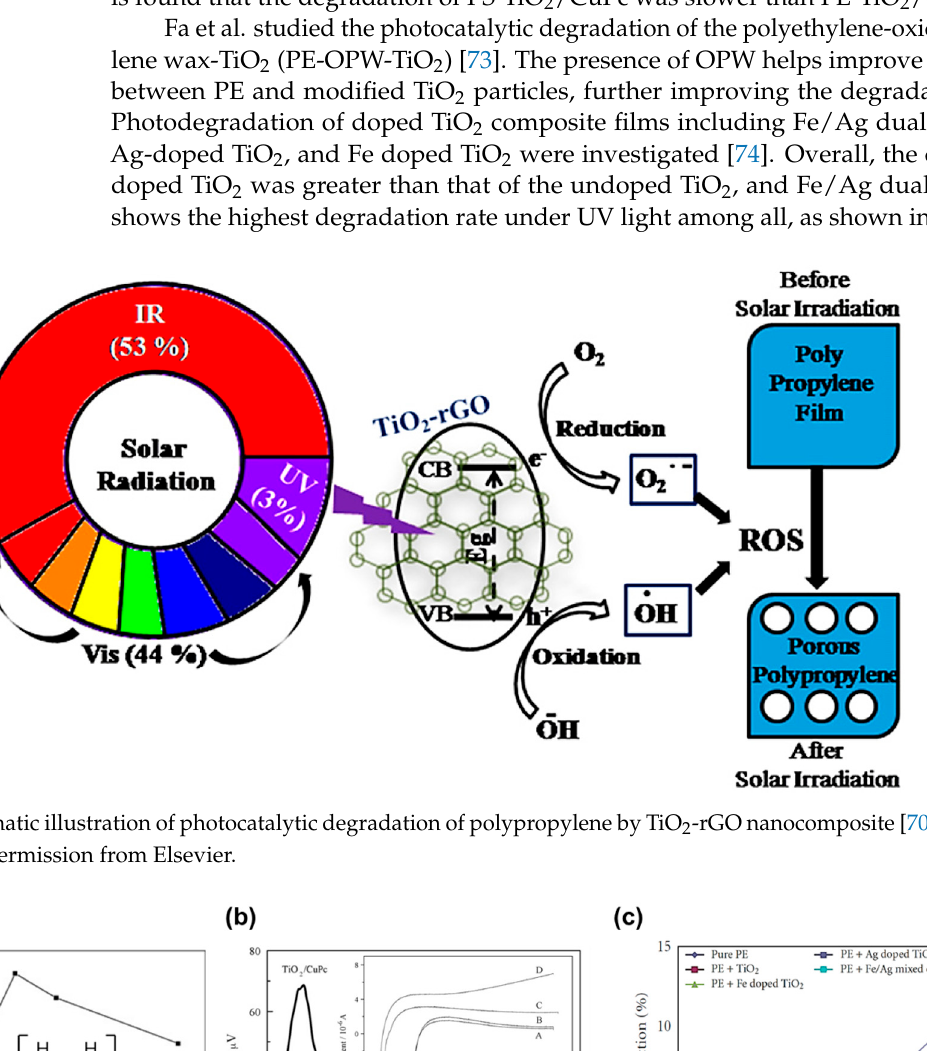
Figure 13 . SEM images of PP nano-composite samples after 500 h of UV irradiation. ( a ) Pure PP, ( b ) PP5Ti, ( c ) PP10Ti, ( d ) PP30Ti, and ( e ) PPDTi [69].